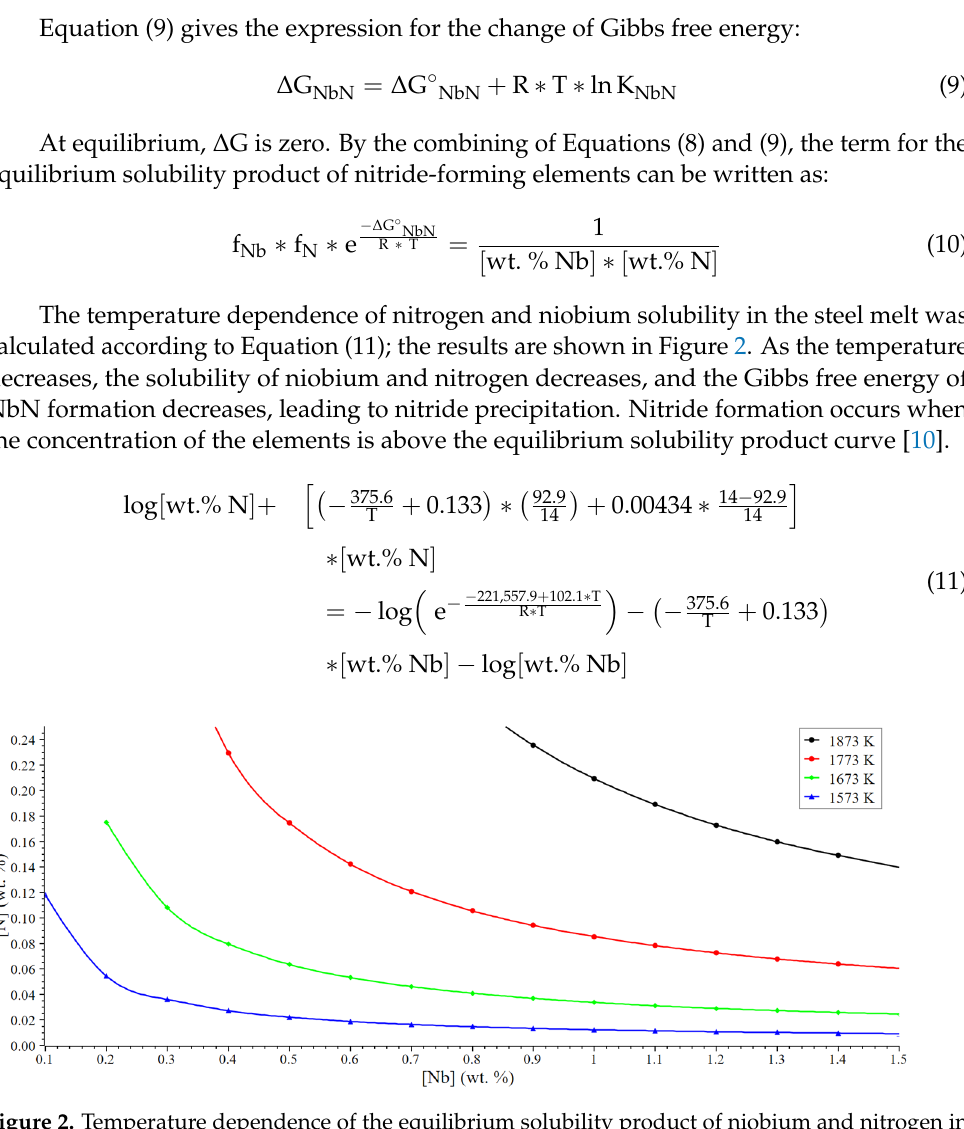
Figure 3. Effect of chromium and nickel addition on equilibrium solubility product of niobium and nitrogen in steel melt at 1773 K. 3.2. Microsegregations of Niobium and Nitrogen Assuming that, in reality, solidification is non-equilibrium, there are differences in the chemical composition and, consequently, non-equilibrium microstructural phases form. Models, described in Table 7, were used to calculate niobium and nitrogen segrega- tions during solidification. C L − i represents the concentration of the alloying element i in the liquid at solid–liquid interface, C 0 − i is the initial concentration of the alloying element